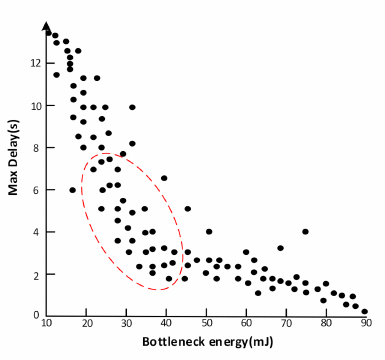
Figure 8. Solution set of multi-objective particle swarm